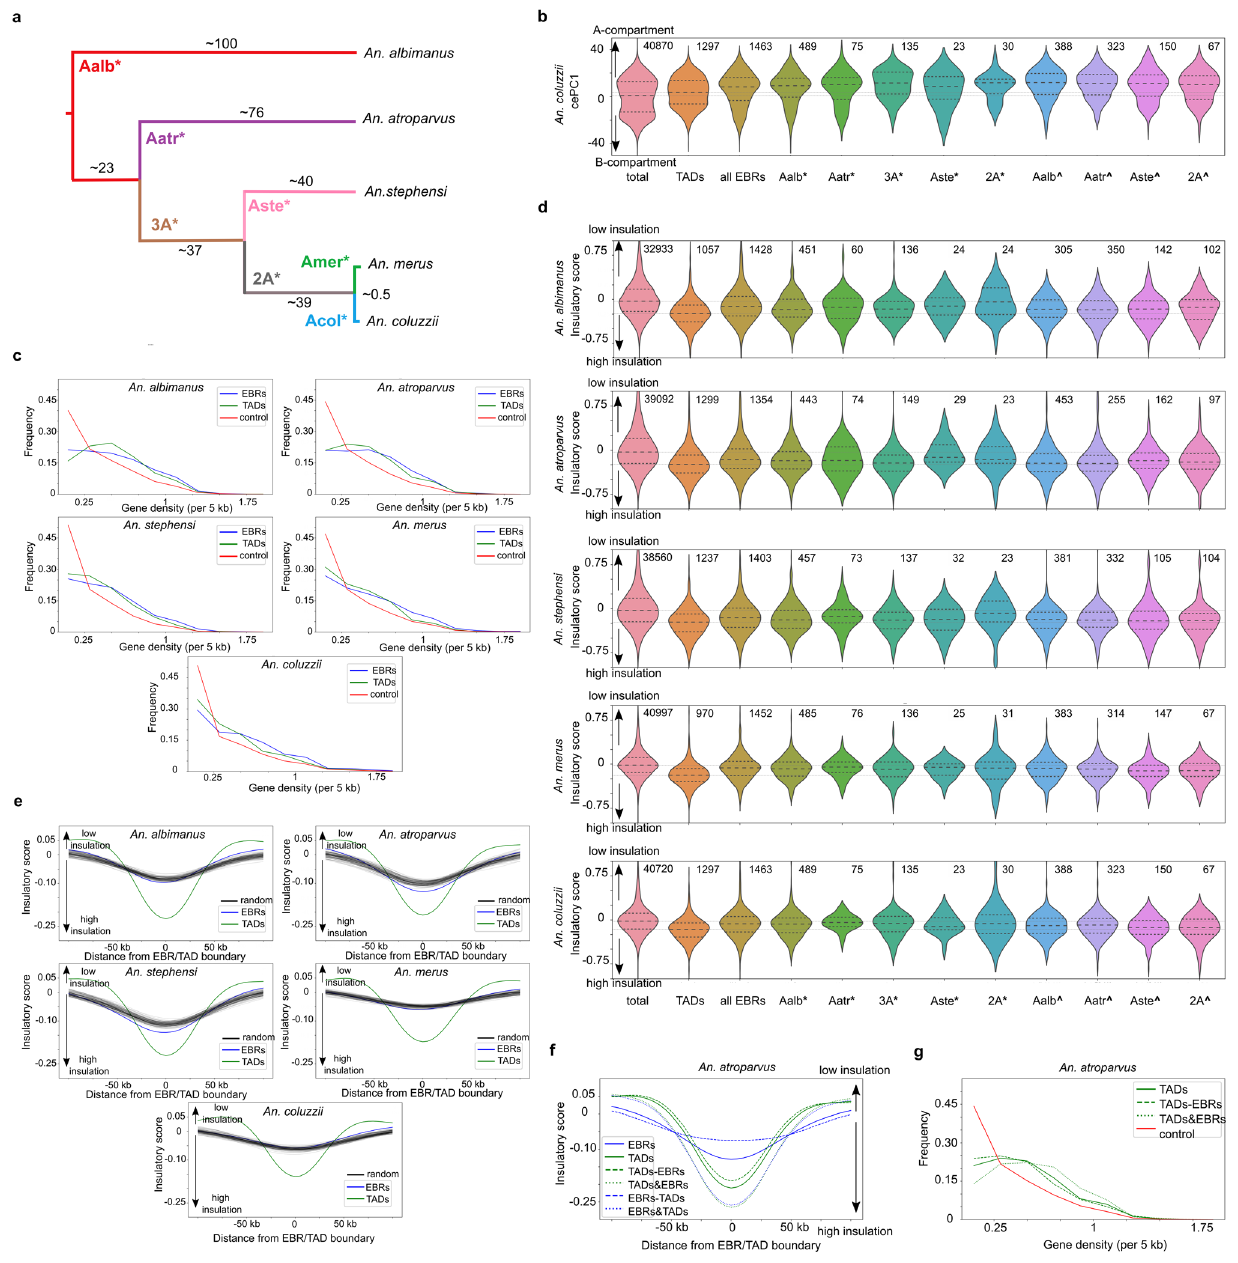
Fig. 8 Evolutionary comparison of spatial genome organization in fi ve Anopheles species. a Phylogeny showing EBR classes; 3A* corresponds to rearrangements that occured in the common ancestor of three Anopheles species ( An. coluzzii , An. merus , and An. stephensi ); 2A* corresponds to rearrangements shared by An. coluzzii and An. merus ; b cePC1 value distributions in the An. coluzzii genome. Labels on the X axis correspond to the different EBR classes where reused breakpoints are marked with circum fl ex “ ^ ” and lineage-speci fi c breakpoints with asterisk “ * ” . Violin-plots show genome-wide distribution (total), distribution observed at TAD boundaries (TADs) followed by distributions for each class of EBRs. Numbers of EBRs are shown above each violin-plot; c Gene density at EBRs; Y -axis shows percentage of genomic bins for each gene of the density group depicted on X -axis; d Insulation of TAD boundaries and EBRs. Data are shown as in b ; e Insulation of EBRs (blue line) and TAD boundaries (green line) compared to randomized controls with gene density matching EBRs (black lines); f , g Insulation ( f ) and gene density ( g ) for regions containing both TAD boundaries and EBRs (TADs&EBRs) and containing only TAD boundaries (TADs-EBRs) or only EBRs (EBRs-TADs). Y -axes show insulation ( f ) or percentage of genomic bins for each gene density group ( g